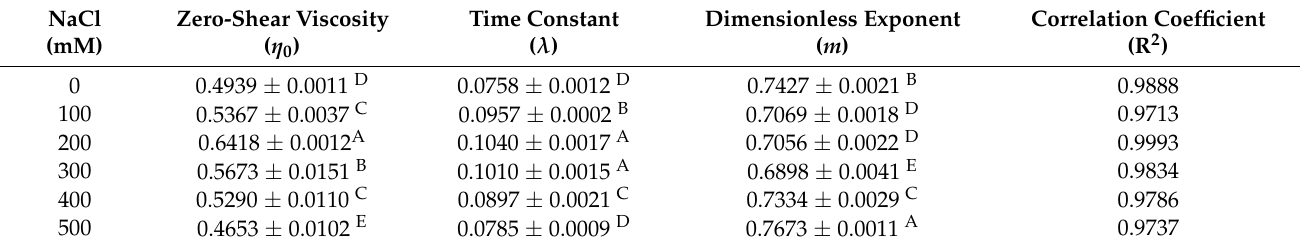
Figure 4. Effects of NaCl concentration on the apparent viscosity of filled hydrogels. Table 2. Effects of NaCl concentration on the steady shear parameter of filled